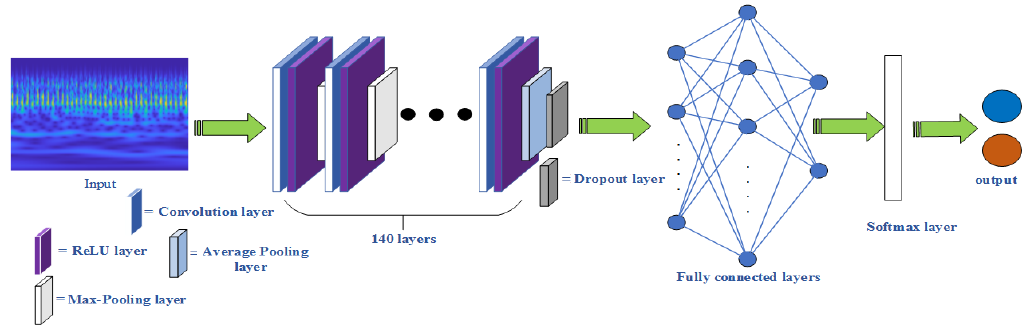
Figure 11. GoogLeNet network structure.